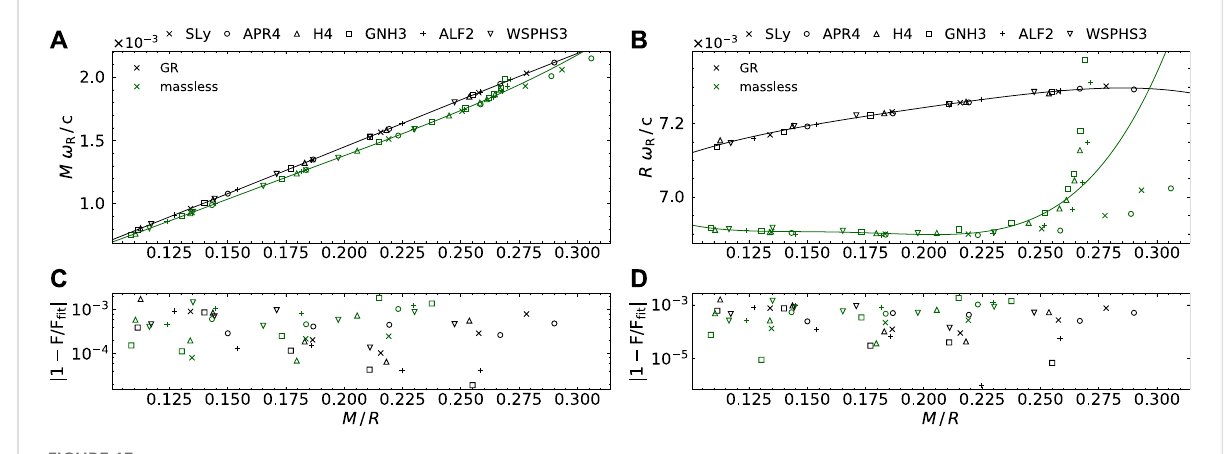
FIGURE 13 Radial ϕ -modeuniversal relations: dimensionless frequency M ω R / cversus compactness C = M / R (A) and fi terrors (C) ;dimensionless frequency R ω R / cversus compactness C (B) and fi terrors (D) .Thesymbolsindicatetherespectiveequationofstate.Themasslessscalar – tensorcaseisshownin green, and the general relativistic case is shown in black.